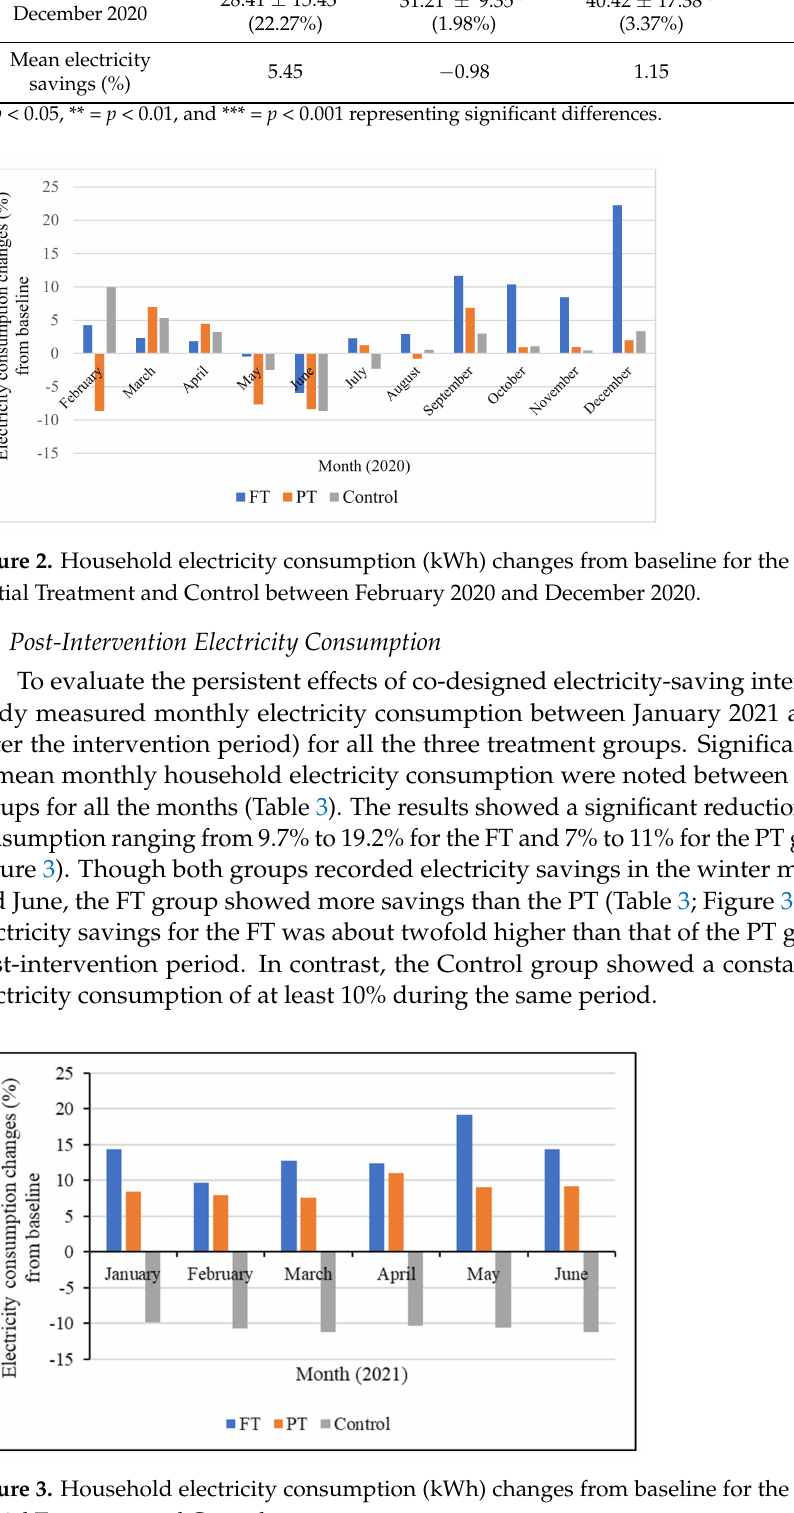
Figure 3. Household electricity consumption (kWh) changes from baseline for the Full Treatment, Partial Treatment, and